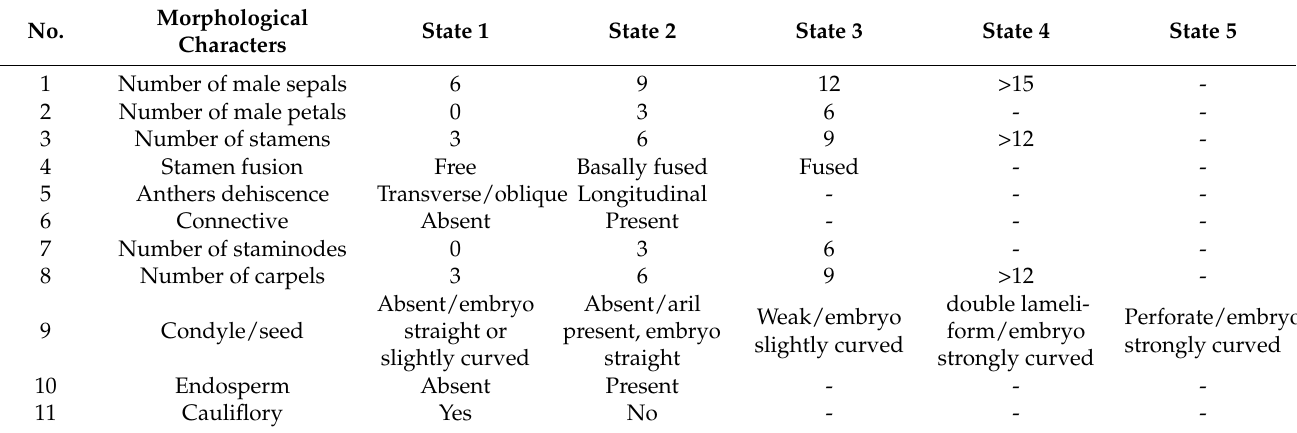
Table A1. Morphological characters and character states used in this